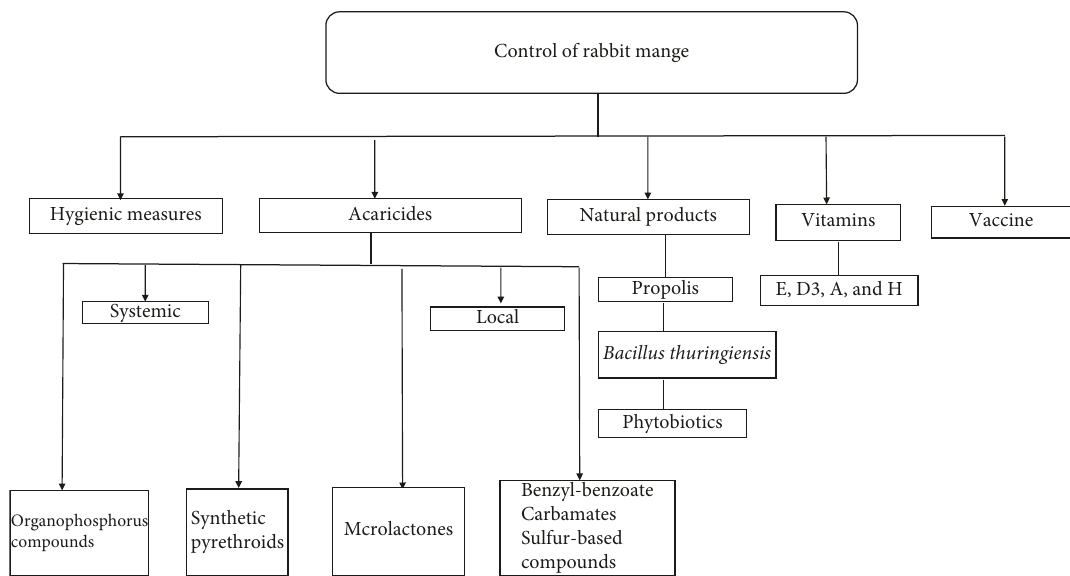
Figure 2: Different strategies to control mange in